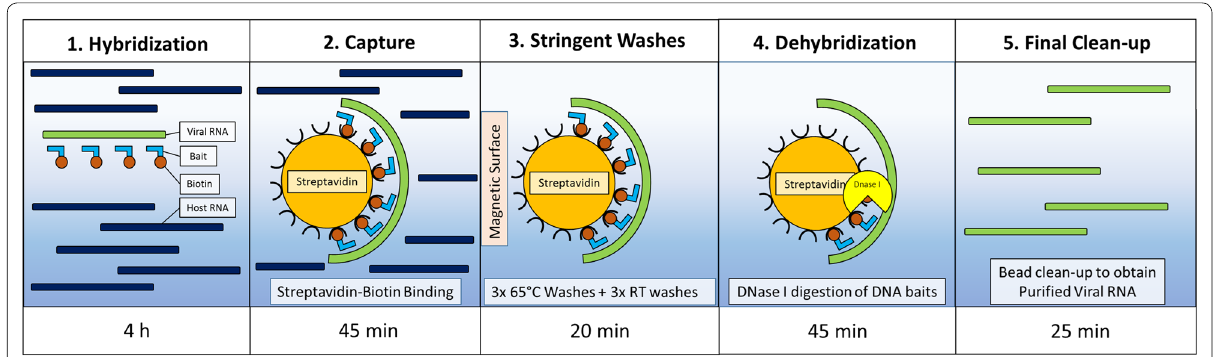
Fig. 1 Capture‑based purification